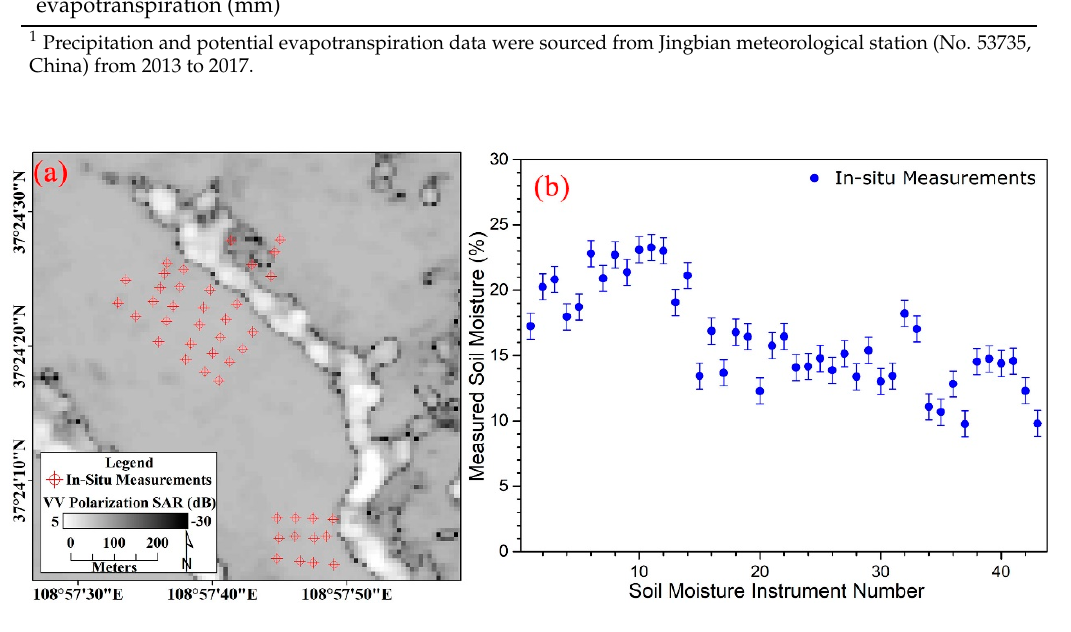
Figure 2. ( a ) Location of the in situ measurements plotted on the Sentinel-1A VV polarization map in dB. The spatial extent is indicated by the blue rectangle in Figure 1b; ( b ) The soil moisture (% volume) of the in situ measurements. The error bars (±1%) were dependent on the accuracy of soil moisture instrument.